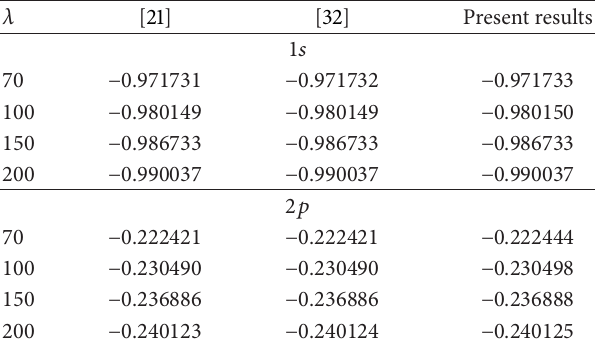
Table 1: When 𝑏 = 𝑐 = 0 , comparison of 1𝑠 and 2𝑝 energy eigenvalues obtained in the present study with results of [21, 32] for different 𝜆 parameters in Rydberg